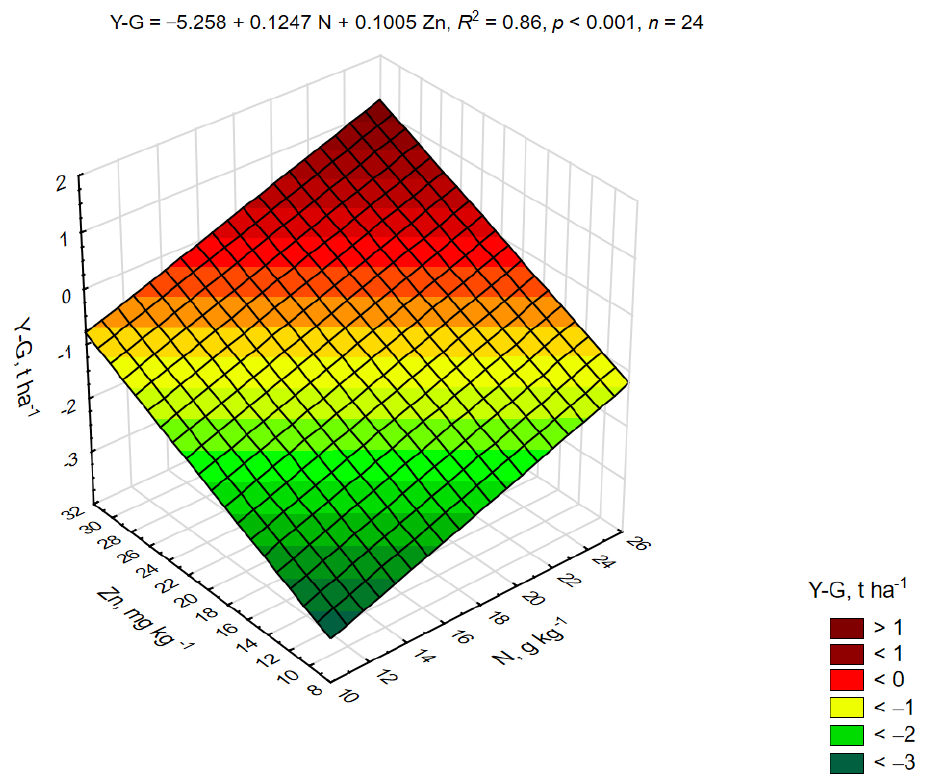
Figure 3. The grain yield-gap (GY-L) as a function of contents of N and Zn in spelt leaves at heading.